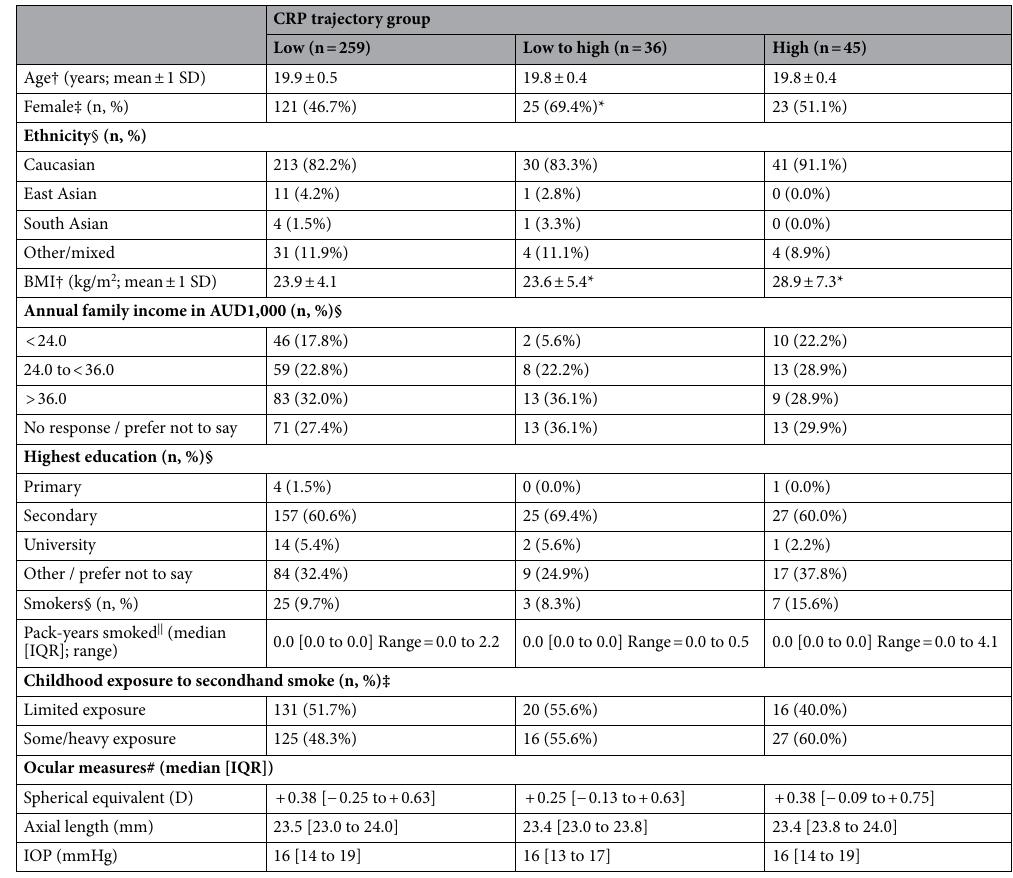
Table 2. Study sample characteristics for the choroidal thickness analyses (n = 341). BMI = body mass index; CRP = c-reactive protein; IOP = intraocular pressure; IQR = interquartile range; SD = standard deviation. *Statistically different from the “Low” group at p < 0.001; †group difference analysed using one-way analysis of variance; ‡analysed using Chi-squared test; §analysed using Fisher exact test; || range additionally shown as median and IQR values are all 0, analysed using the using the Kruskal–Wallis test; #analysed using generalised estimating